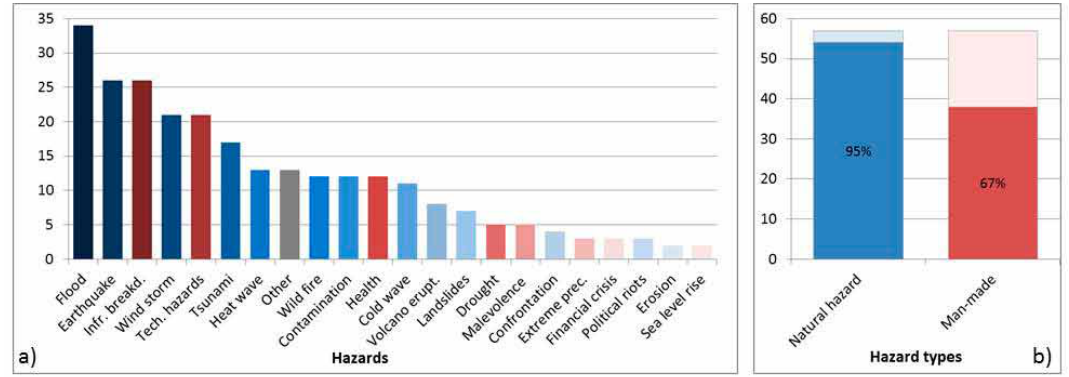
fig. 2. natural (blue shades) and man-made (red shades) hazards considered in the projects (a) and number of projects including natural and man-made hazards as a percentage of the total number of projects